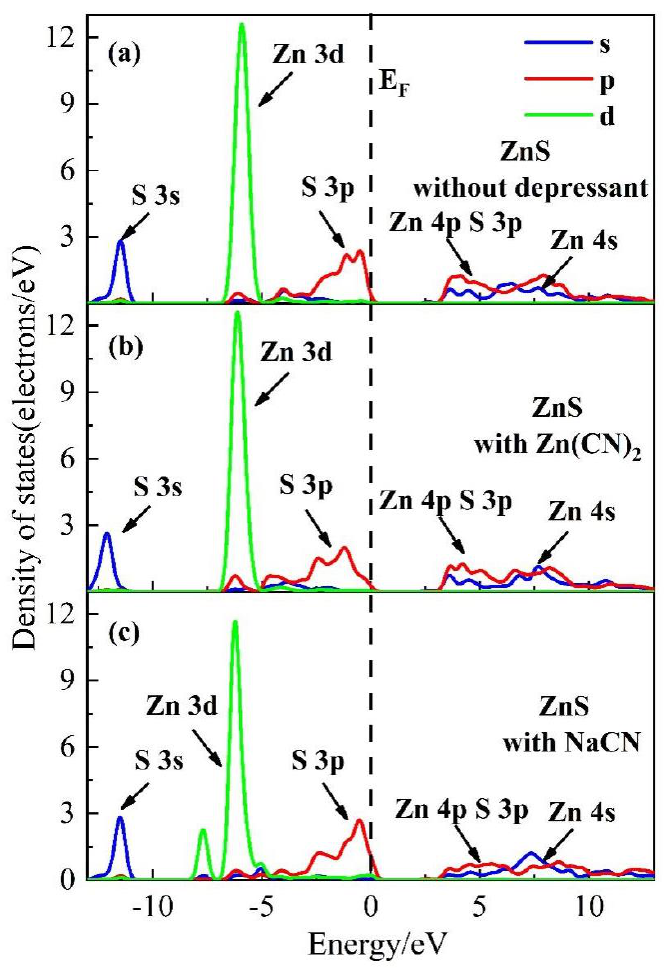
Figure 6. ( a ) ZnS, ( b ) ZnS with Zn(CN) 2 , and ( c ) ZnS with NaCN Zn and S atom partial density of state